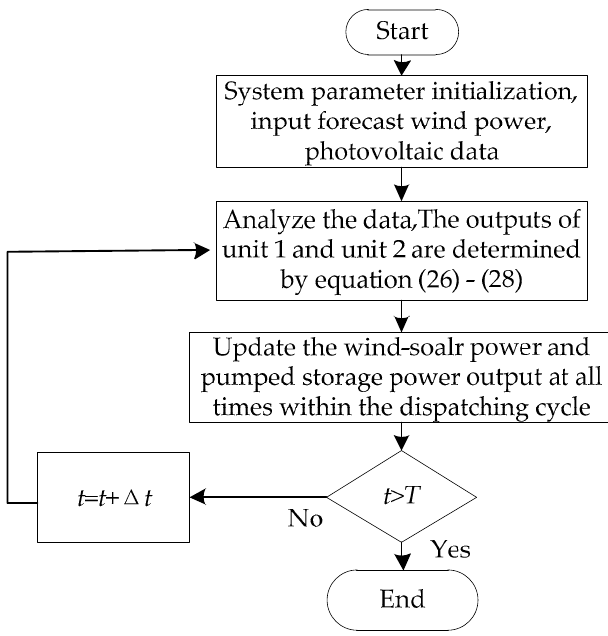
Figure 2. Flowchart of new control strategy.